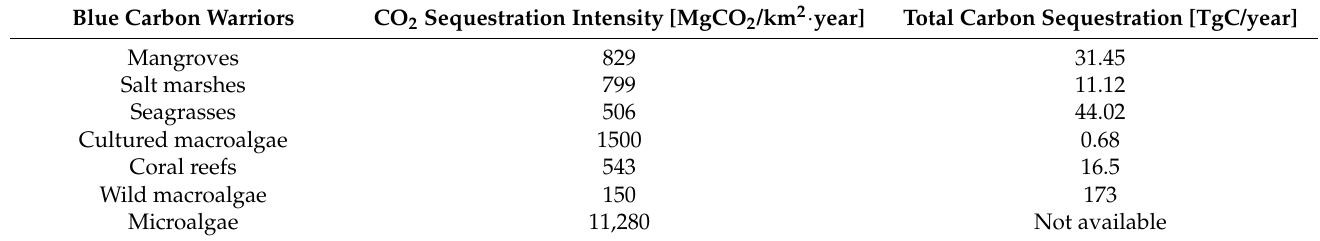
Table 6. Mechanism and contribution of microalgae to the blue carbon